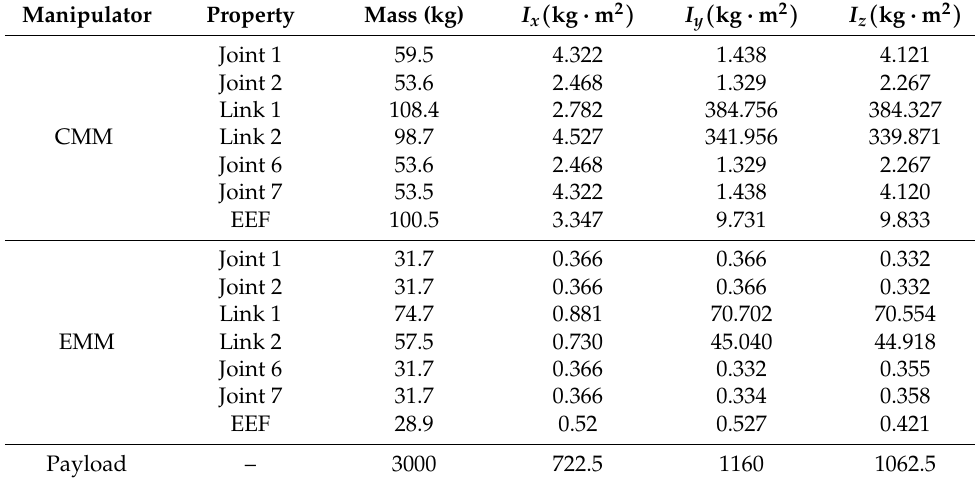
Table 3. Mass properties of the